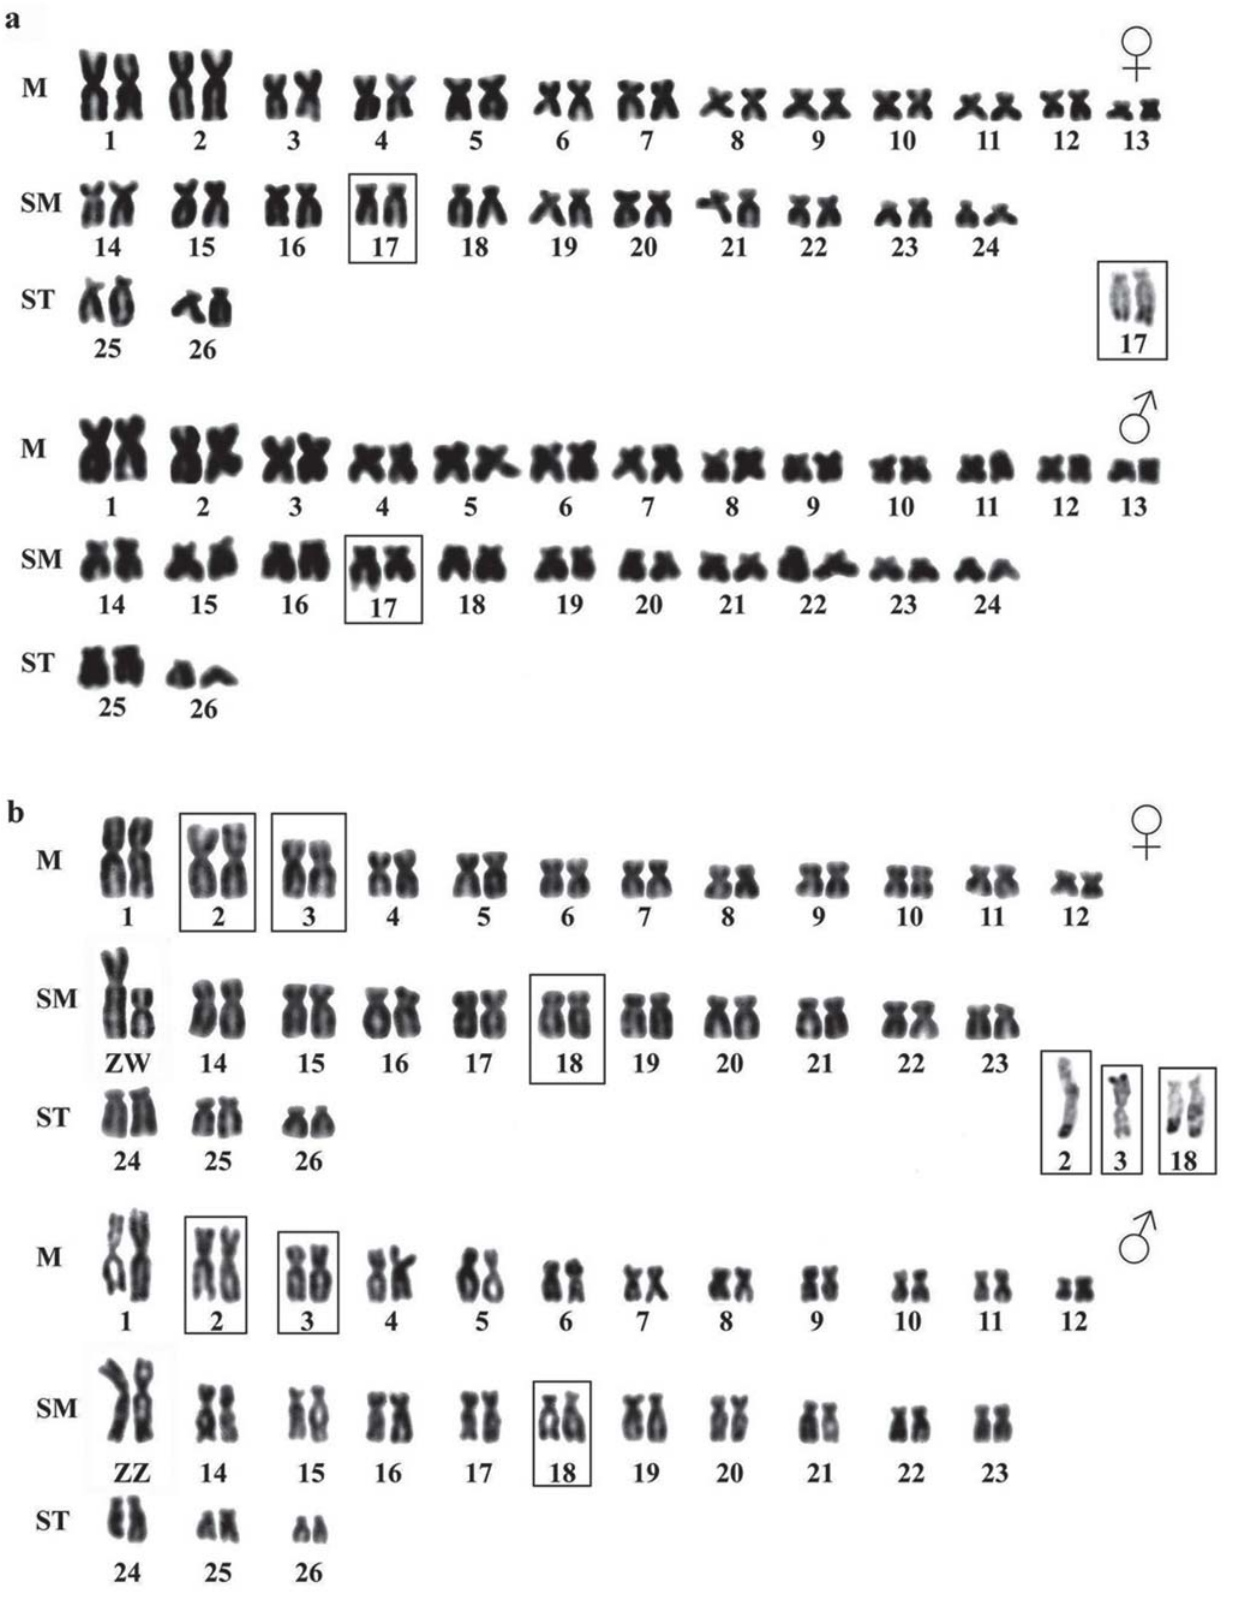
Fig. 2. Karyotypes of female and male of Hemiancistrus spinosissimus (a) and Hemiancistrus spilomma (b), with conven- tional Giemsa staining. The chromosome pair bearing Ag-NORs are in the